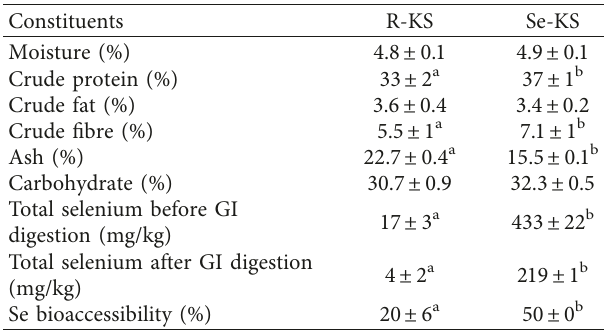
Table 1: Physicochemical contents, total selenium, and Se bio- accessibility of air-dried substance of regular Chinese kale seedlings (R-KS) and Se-enriched Chinese kale seedlings (Se-KS).